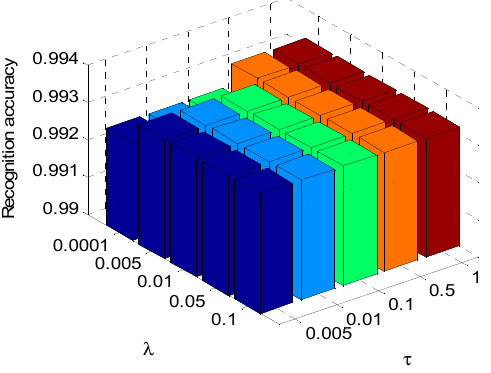
Figure 11. Recognition rate of ALADPL with the regularization parameters.